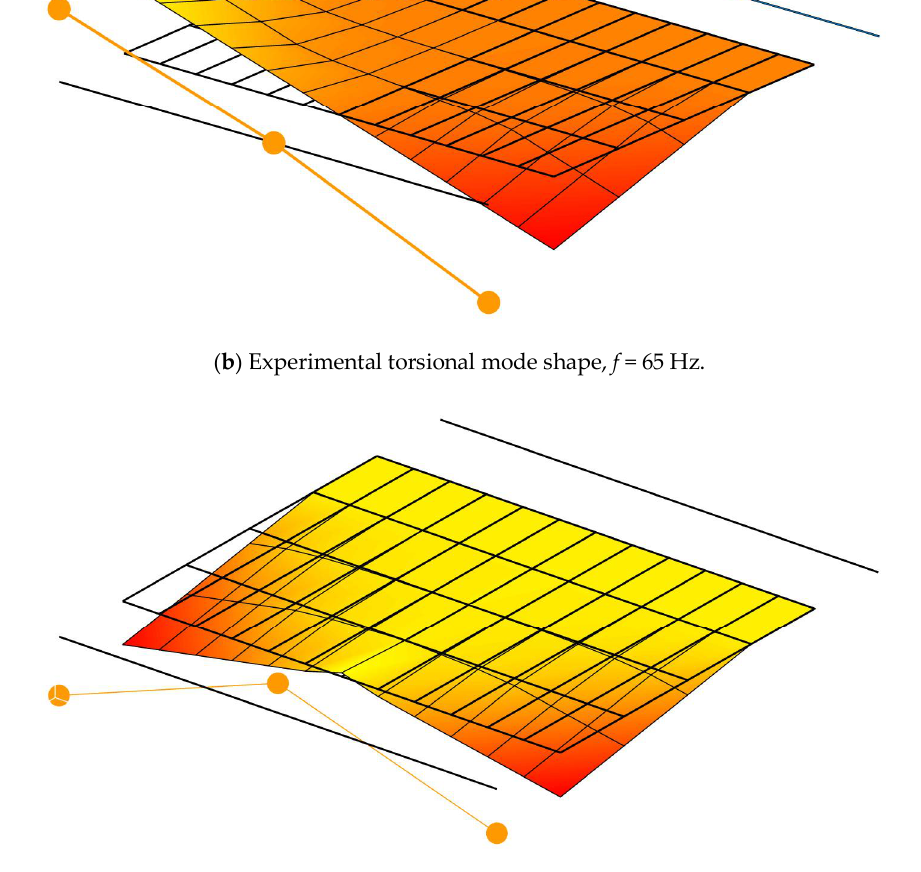
Figure 23. Experimental mode shapes.